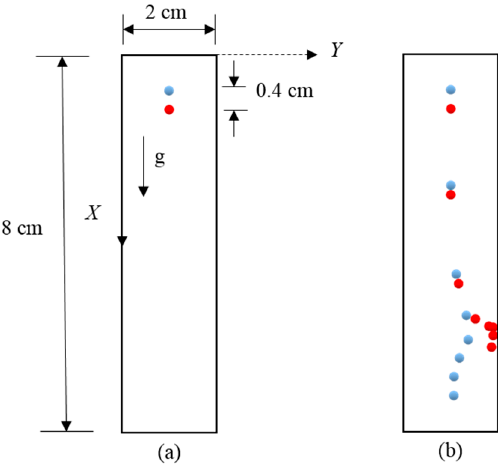
Figure 3. The benchmark case of two particles sedimentation. ( a ) The geometry of the simulation; ( b ) the settling trajectory of two-particle sedimentation.